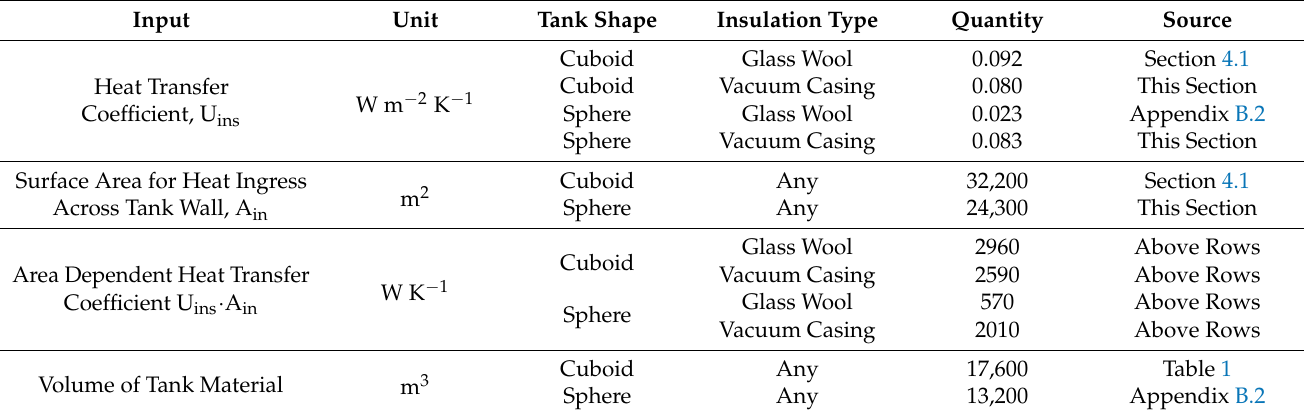
Table A5. Area-dependent heat transfer coefficient and volume of tank material for four tanks of insulation thickness of 0.53 m. Values for spherical and cuboidal tanks with glass wool and vacuum casing insulation are shown